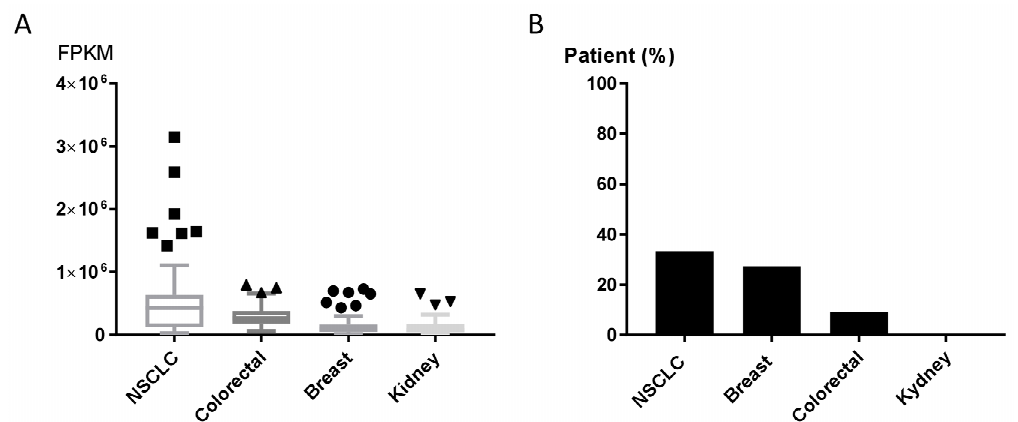
Figure 5. ( A ) GPT2 RNA expression as RNA-seq data retrieved from The Cancer Genome Atlas (TCGA) for NSCLC, colorectal, breast and kidney cancer patients. ( B ) GPT2 protein levels; bars indicate the percentage of patients (12 patients) with high and medium protein expression levels obtained from the Human Protein Atlas [25].